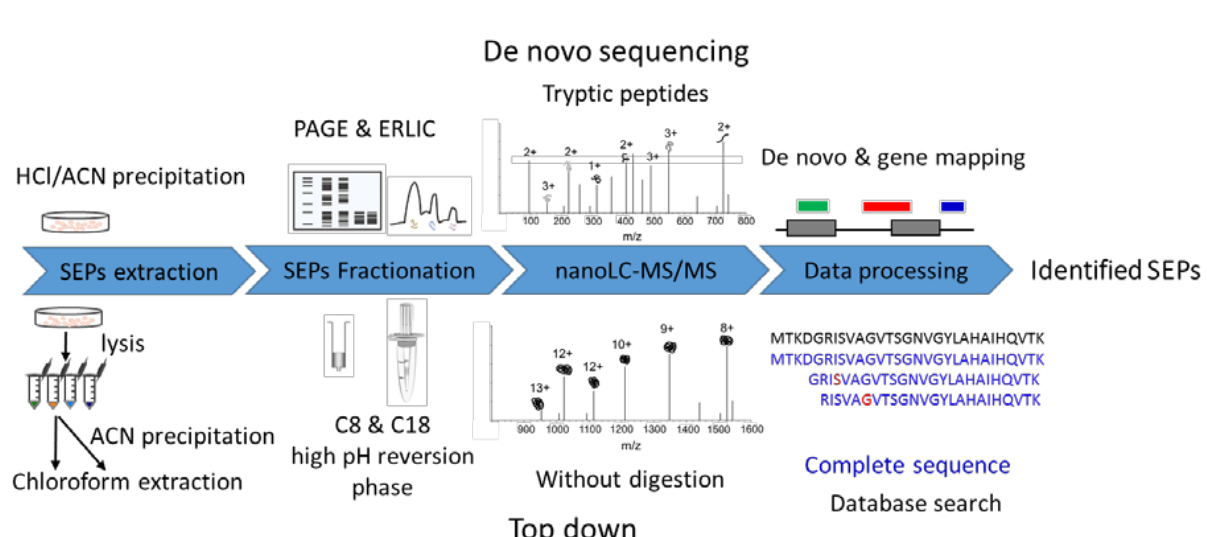
Figure 1. Workflow for SEP identification. De novo sequencing strategy: raw data from bottom-up experiment loaded to pNovo for sequencing, then the de novo specific peptides were filtered and mapped to the genome to define new open reading frames, obtaining entire sequences of SEPs. Top-down strategy: SEPs were enriched, fractionated, and analyzed by liquid chromatography-tandem mass spectrometry (LC/MS/MS) without further digestion. Raw data were searched against a constructed database including proteins in UniProt and OpenProt database to identify SEPs.